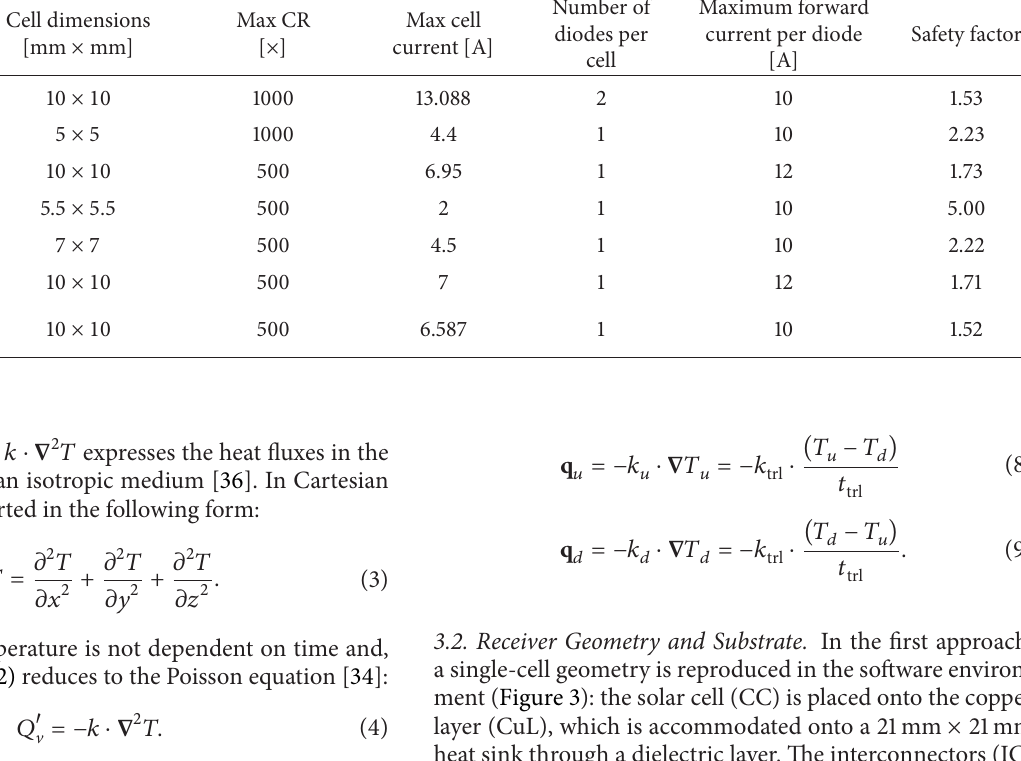
layer (CuL), which is accommodated onto a 21 mm × 21